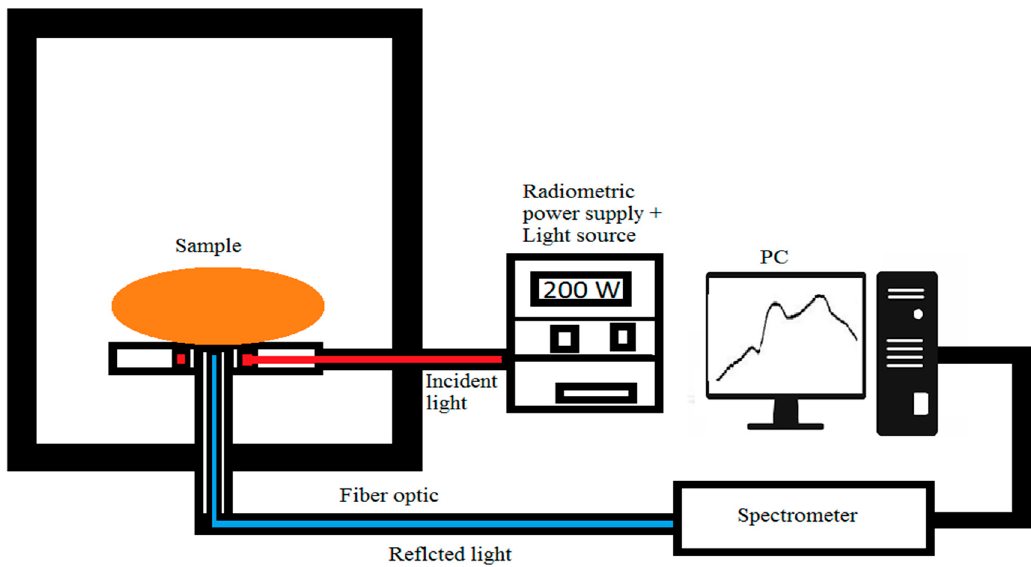
Figure 1. Schematic representation of the visible (VIS)/near-infrared (NIR) interactance testing of Frito Lay 1879 Frito Lay 1879 (FL1879) and Russet Norkotah (R.Burbank) potato Lay 1879 Frito Lay 1879 (FL1879) and Russet Norkotah (R.Burbank) potato cultivars.